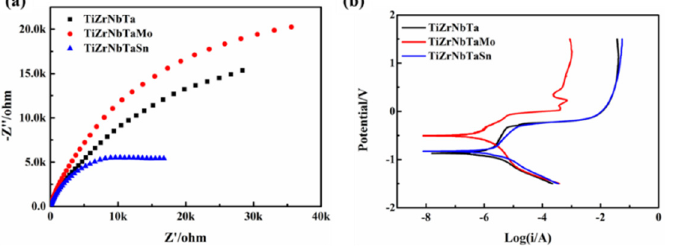
Figure 3. ( a ) Nyquist diagram and ( b ) corresponding polarization curves of high entropy alloys. Table 1. Parameters of electrochemical corrosion of high entropy alloy. Alloy